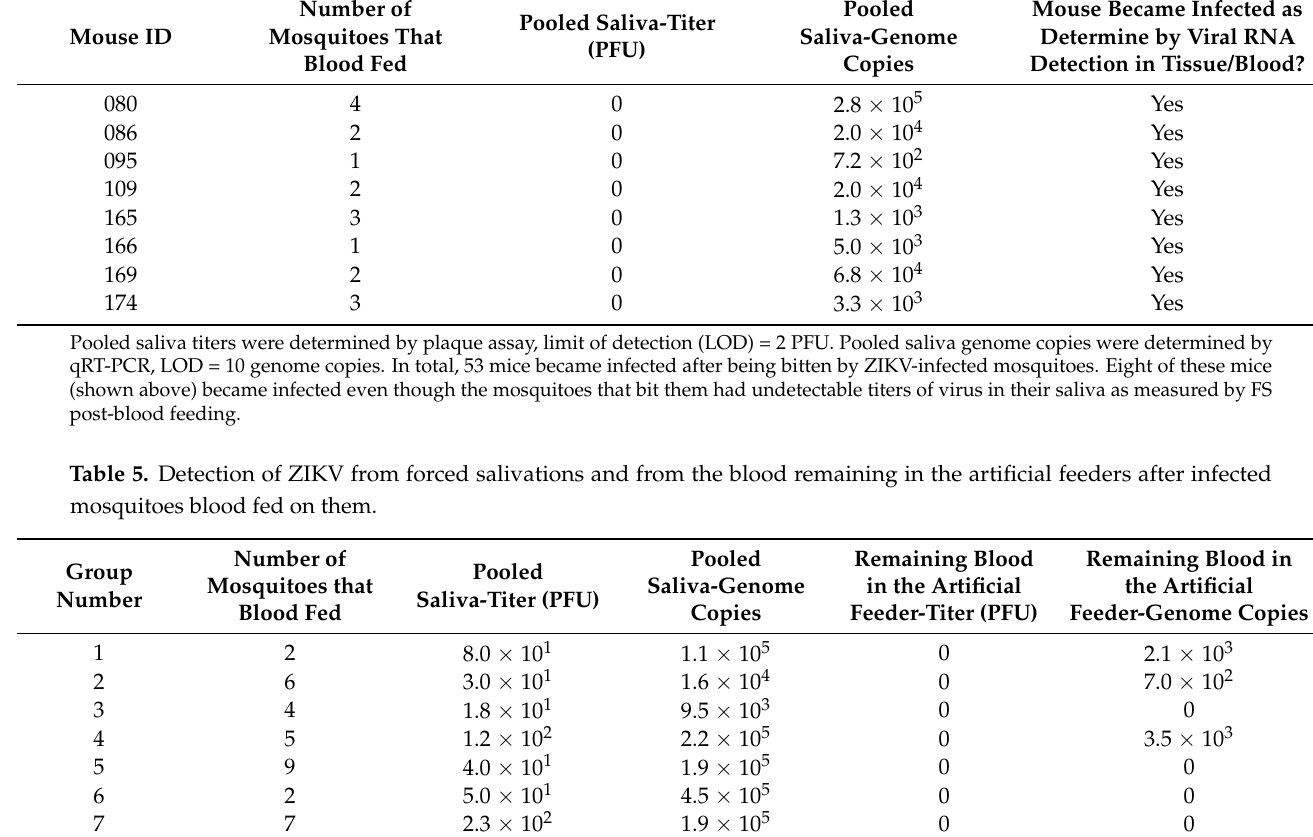
Mouse Became Infected as Pooled Determine by Viral RNA Copies